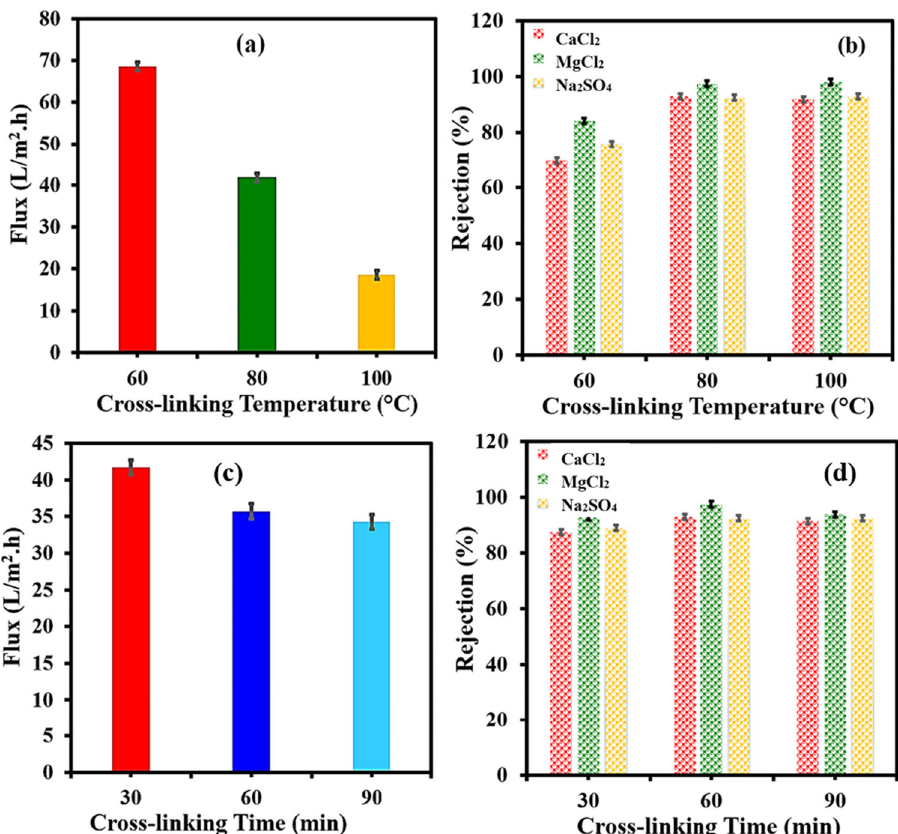
Fig. 6 Study of various factors on membrane performance. Effect of cross-linking temperature on a water fl ux and b salt rejection at constant pressure (20 Bar) and constant cross-linking time (30 min). c Effect of cross-linking time on water fl ux and d salt rejection at constant temperature (80 °C) and constant pressure (20